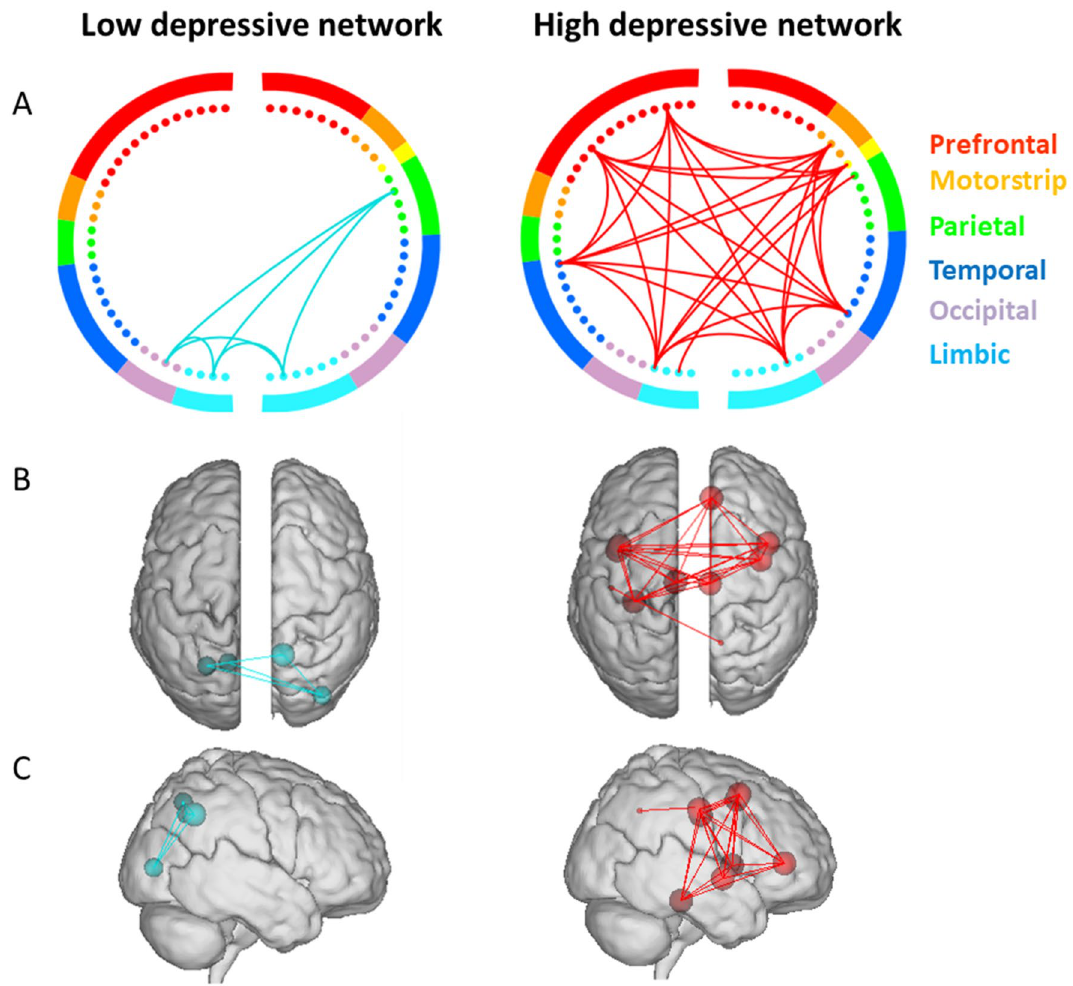
Figure 2. Depictions of the high- and low-depressive networks. Circle plots ( A ), glass brains—top view ( B ), glass brain- right view were obtained by keeping the significant edges (p < 0.01, FDR corrected). Colors within the circle plots correspond to lobes of the